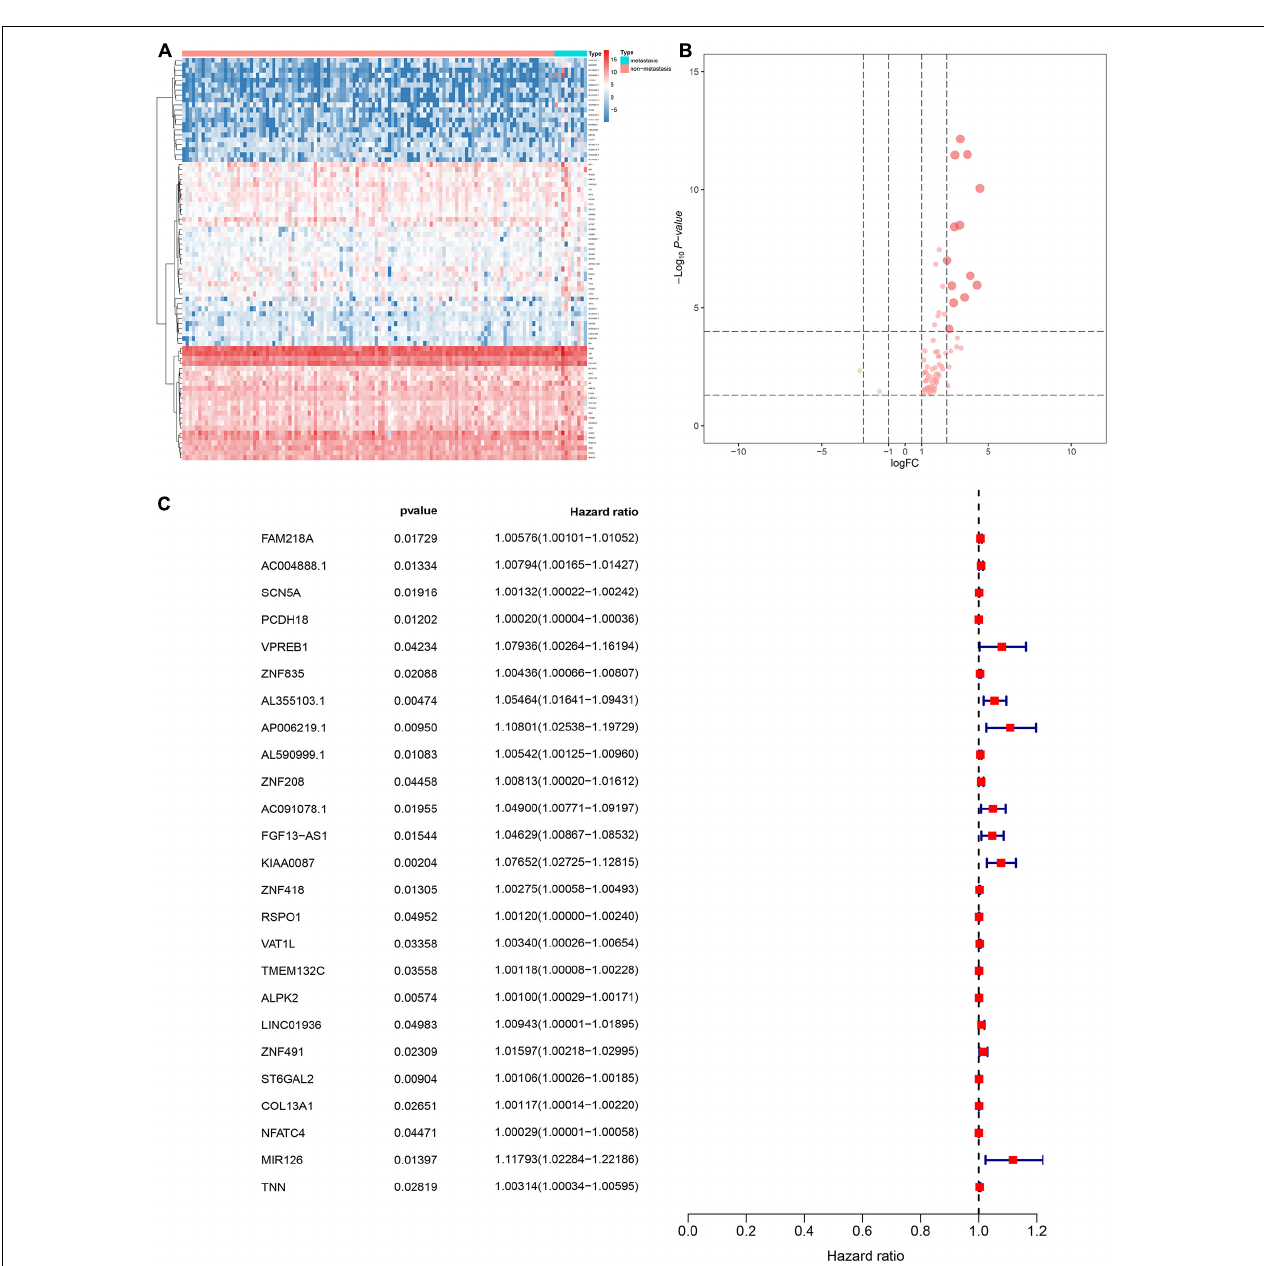
illustrated the differential expression levels of 50